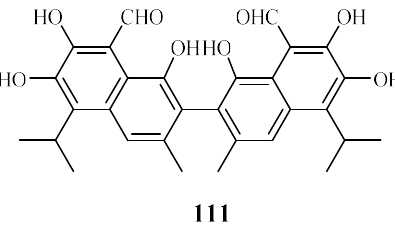
Figure 23. Compounds from a Malvaceae plant.